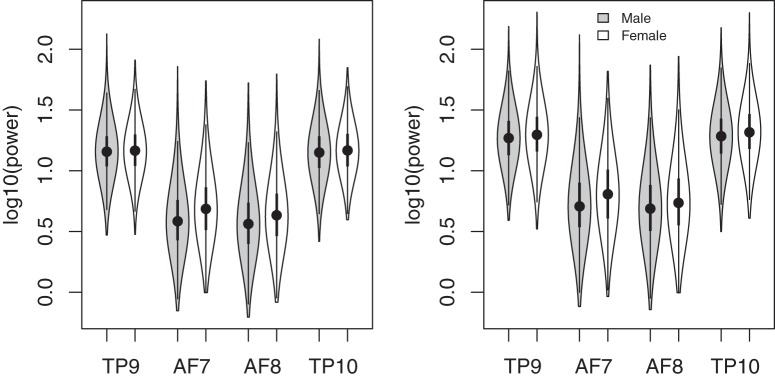
Log10-transformed EEG power in the 0- to 30-Hz range measured in females (white) and males (gray) at each channel for NFB (left) and CAL (right), shown in the form of violin plots (Hintze and Nelson, 1998). Filled circles represent the median, and the first and third quartiles are identified by the bottom and top of the bold vertical lines, respectively. The bottom and top of the thin vertical line represent the lower and upper adjacent values, respectively. Females had slightly higher power at all channels, regardless of task.